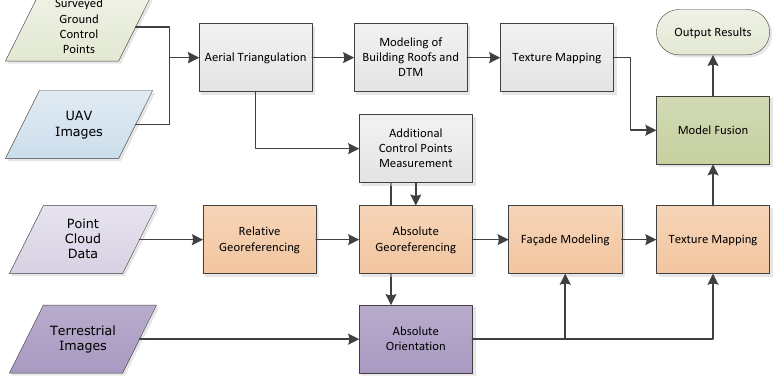
Figure 1: Flowchart of the data processing